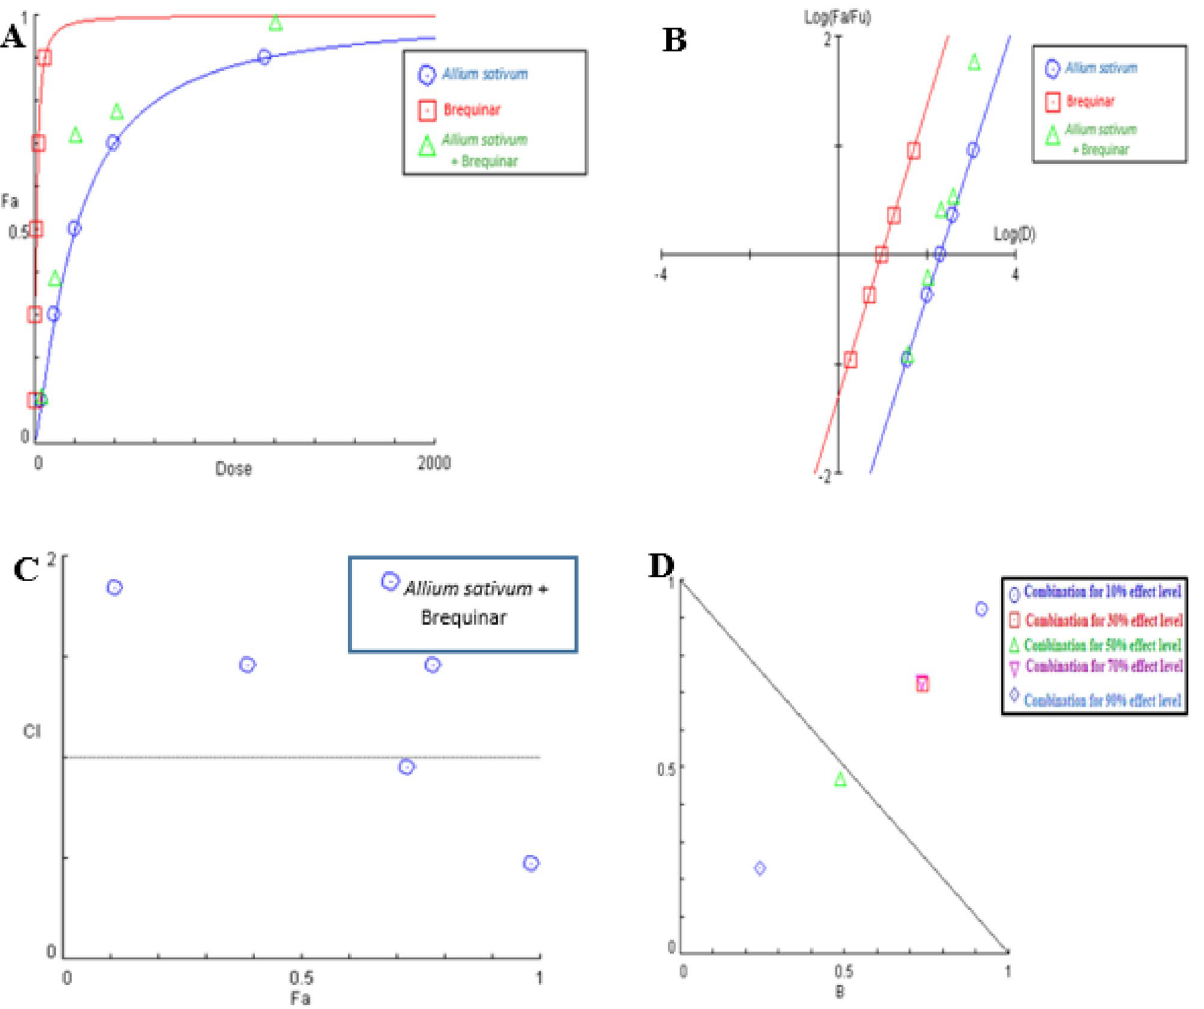
Figure 11. Analysis of Allium sativum extract and brequinar combination: ( A ) dose-effect curve and its linearization with ( B ) median-effect plot for each single drug and combination treatment ( C ) combination index plot and ( D ) dose-normalized isobologram for various effects (10%, 30%, 50%, 70 and 90%) in the combinations of Allium sativum extract and brequinar.